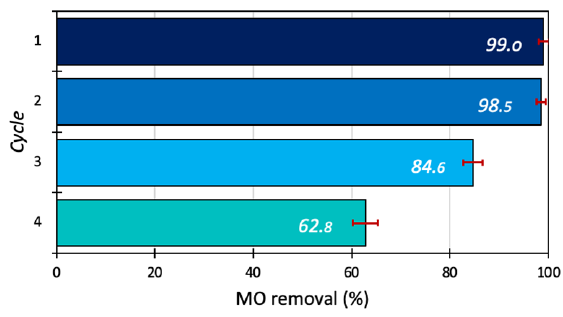
Figure 11. The reusability test of 15BCPC (catalyst dosage 1 g/L, dye concentration 30 mg/L, and pH 5).